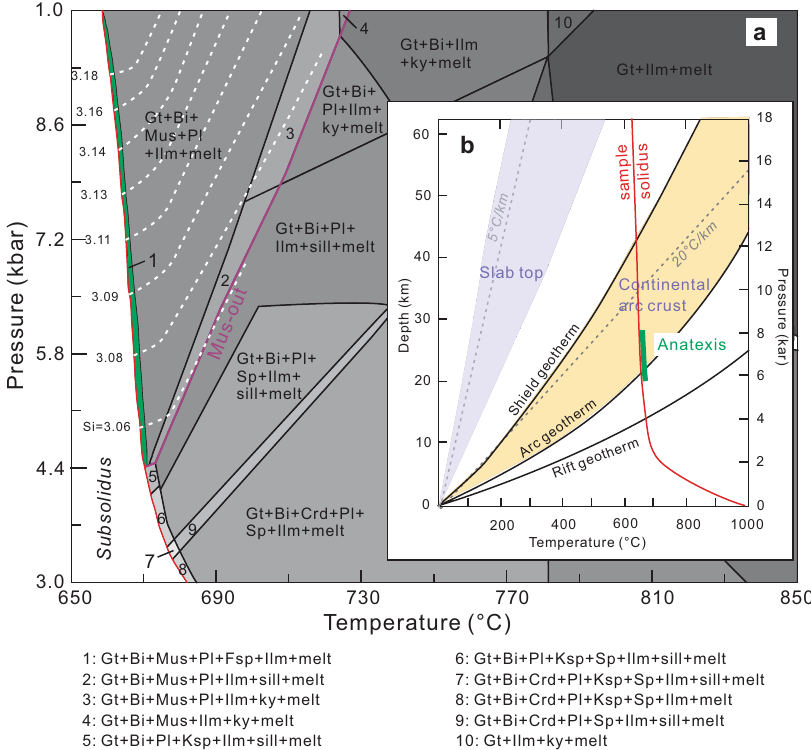
Fig. 2 Reconstructed anatexis P-T conditions for the Pengguan migmatites. a P – T pseudosection calculated for the Pengguan migmatite (16YX-1-1) in the MnNKCFMASH system (Quartz and H 2 O in excess). Internally consistent thermodynamic dataset of Holland and Powell 42 was used. Mineral assemblage in the thin green belt along the solidus is consistent with the mineral composition and fi eld observations of sample 16YX-1-1. The predicted Si isopleths content in muscovite (3.06 – 3.18, in molar per formula unit) are shown by the white dotted lines. Gt – garnet, Bi – biotite, Mus – muscovite, Pl – plagioclase,